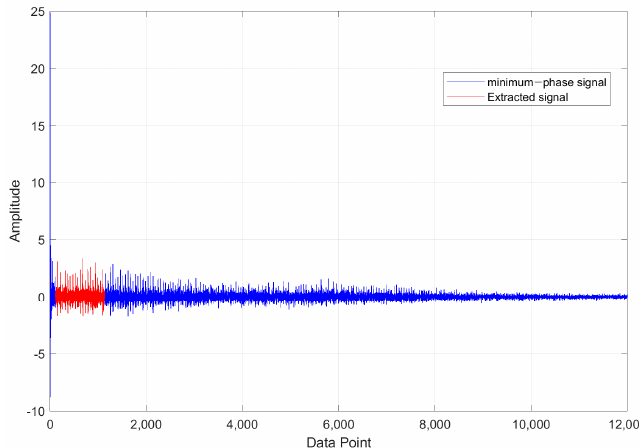
Figure 2. Example of making processed signal.